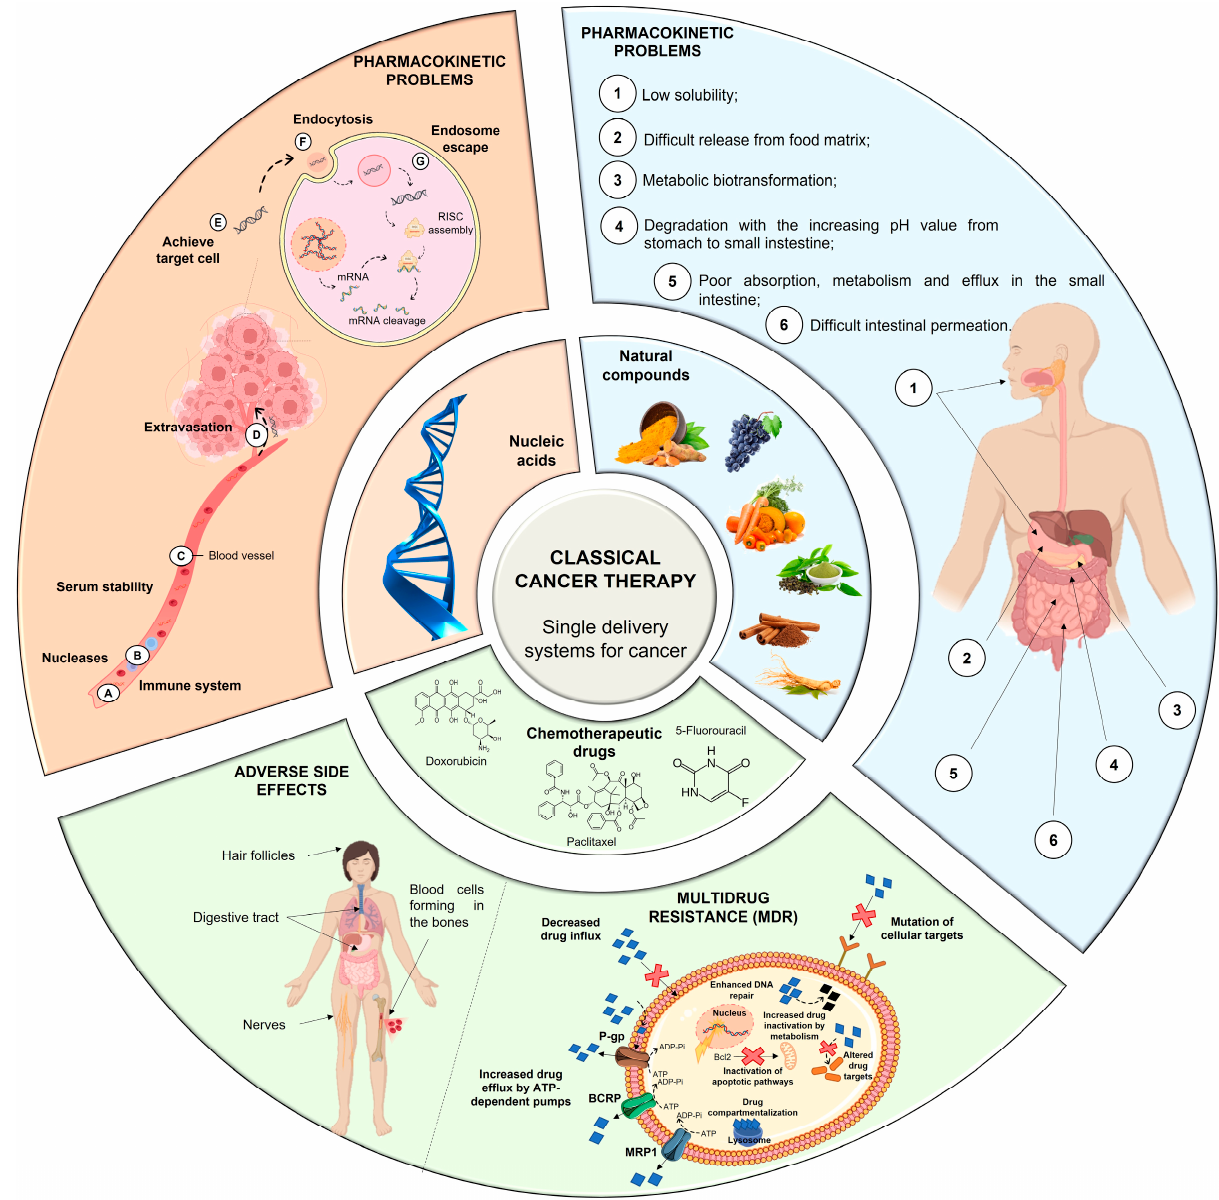
Figure 1. Problems associated with the classical single-delivery therapy (i.e., administration of each of the therapeutic agents in their free form). Nucleic acids, if delivered in the free form, would face different pharmacokinetic challenges, including inactivation by nucleases (A), lack of serum stability due to the immune system (B) and serum proteins (C), extravasation difficulties (D), non-specific distribution in target cells (E), difficulties entering the cell (F), and degradation if not able to escape endosomes (G). Chemotherapeutic drugs, when delivered in the free form, have a nonspecific distribution in cancer cells and healthy cells causing serious adverse side effects, commonly affecting hair follicles, the digestive tract, blood cells and nerves. Furthermore, several MDR mechanisms, such as drug efflux by multidrug resistance protein 1 (MRP1), P-glycoprotein (P-gp), and breast cancer resistance protein (BCRP), or inactivation of apoptotic pathways by B cell leukemia protein (Bcl2), can impair their efficiency. Natural compounds, when administered in their free form, exhibit a number of pharmacokinetic issues that affect their biodistribution and efficacy